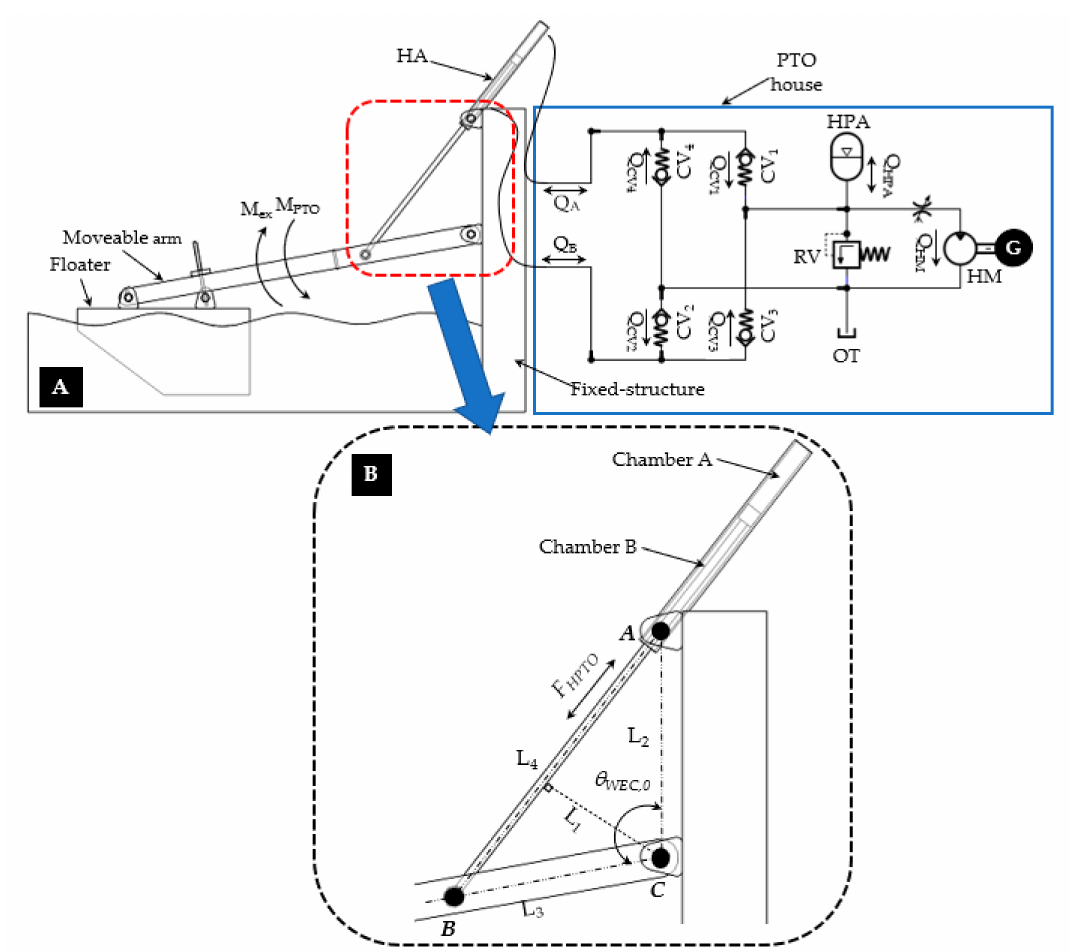
Figure 1. An illustration of WEC with the HPTO unit concept. ( A ) A complete layout design, and ( B ) Enlarge image of the interconnection between HA, floater’s arm and fixed